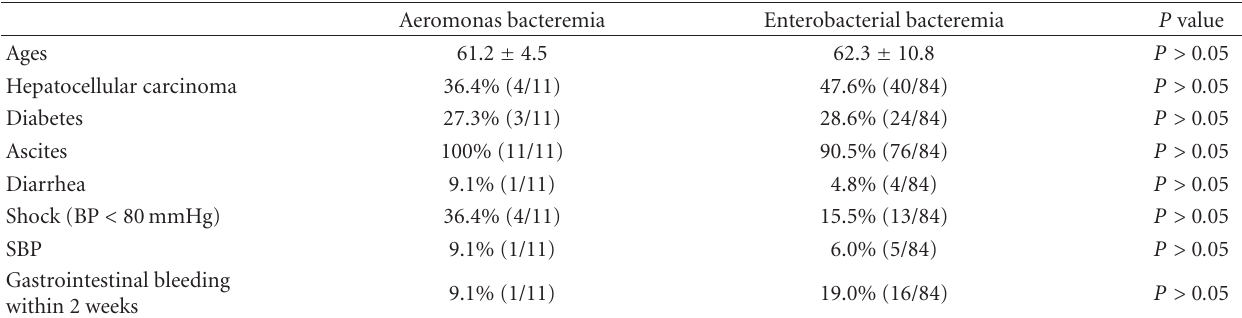
Table 2: Comparison of background factors and clinical findings in the two groups.